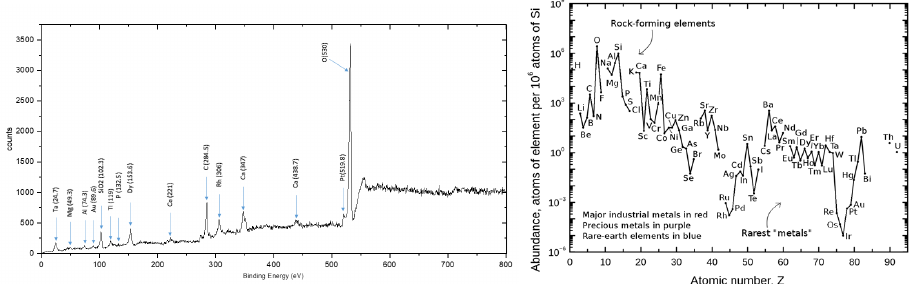
Figure 1. (Left) XPS analysis of indoor concrete powder confirms the presence of C, O, Si, Ca and Mg with the other elements. (Right) Chemical element abundance (fraction of atoms w.r.t 10 6 Si atoms) in the Earth’s upper crust as a function of atomic number [7]